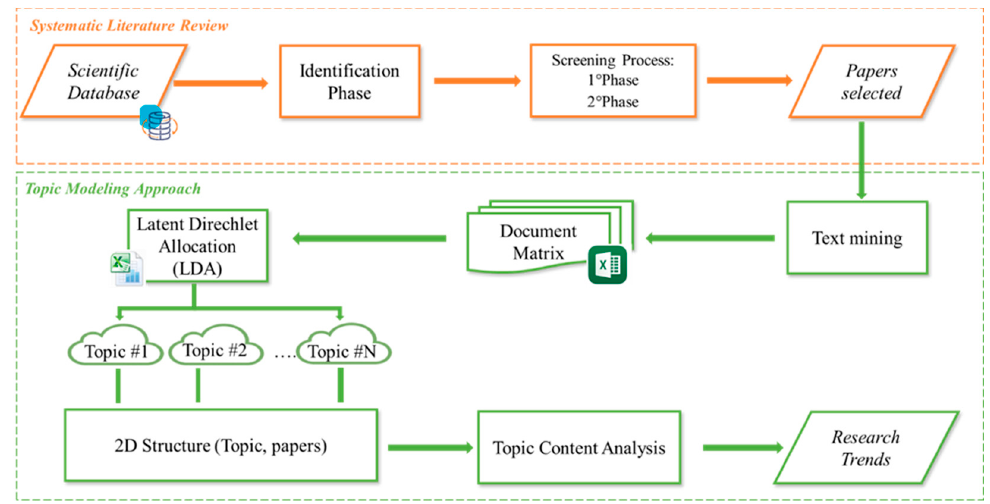
Figure 1. Research method.